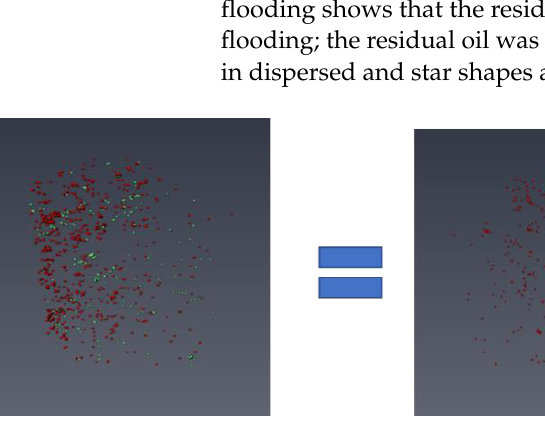
84.22 Figure 22. The Y56 – 19 core displacement efficiency and ratio of volume to total core volume in dif- ferent stages. 4.5. Discussion of Flooding of the Cores The comparison of the different cores before and after displacement shows that the crude oil in the larger pores decreased after the displacement as shown in Figures 23 – 26, indicating that the oil in the macropores and mesopores was recovered, and that the re- maining oil was transformed into smaller oil droplets; the number of oil droplets with a diameter greater than 10 μm was reduced, while the number of oil droplets with a diam- eter less than 10 μm increased. The remaining oil in the produced pores was mainly pre- sent in the form of oil films or corner oil. The alternate injection of gas and water further reduced the remaining oil in the macropores. The proportion of the remaining oil in the medium and small pores was large, which is the key object of tapping the production potential in the later stage. Micro- CT can identify pores with sizes greater than 1 μm; the lower the permeability and porosity, the lower the saturable crude oil. The micro-CT identifiable pore amounts in the Y29 – 100, Y40 – 92, Y53 – 89, and Y56 – 19 cores were 5.3%, 7.07%, 8.8%, and 9.1%, re- spectively; the percentage of the saturated crude oil in the cores was 32%, 81%, 84%, and 86%, respectively. The lower the core permeability, the worse the oil displacement effi- ciency; this is because the micro-heterogeneity of porous media makes the capillary force of displacement quite different, and fingering and around flow become the main oil